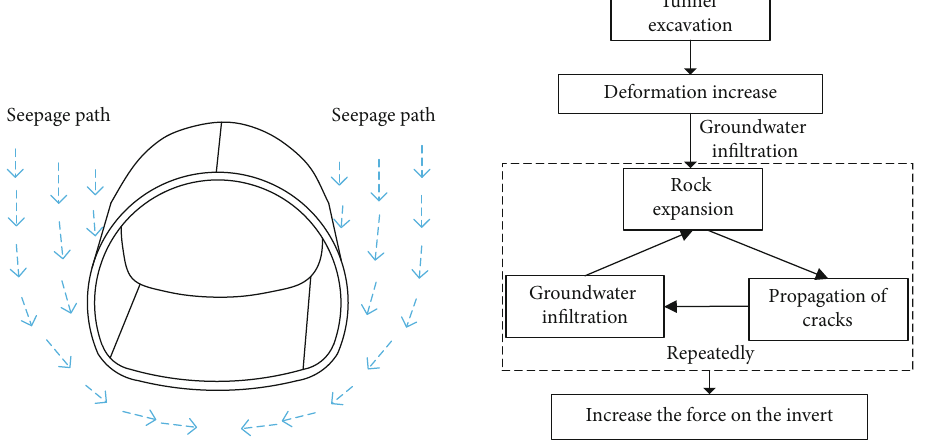
Figure 7: Seepage path and rock expansion process.